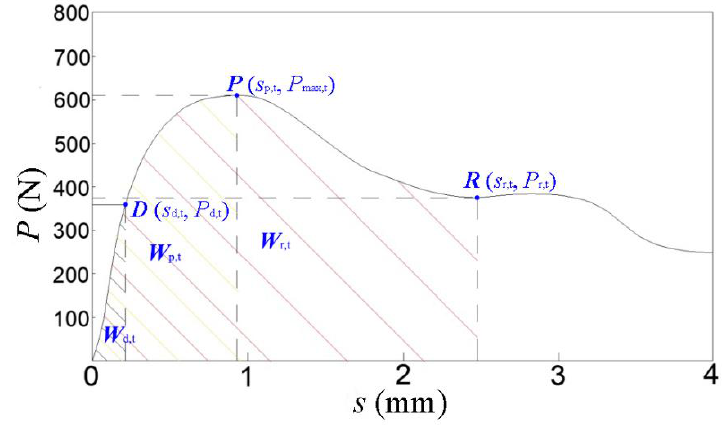
Figure 3. Schematic diagram of three key points and pull-out works.